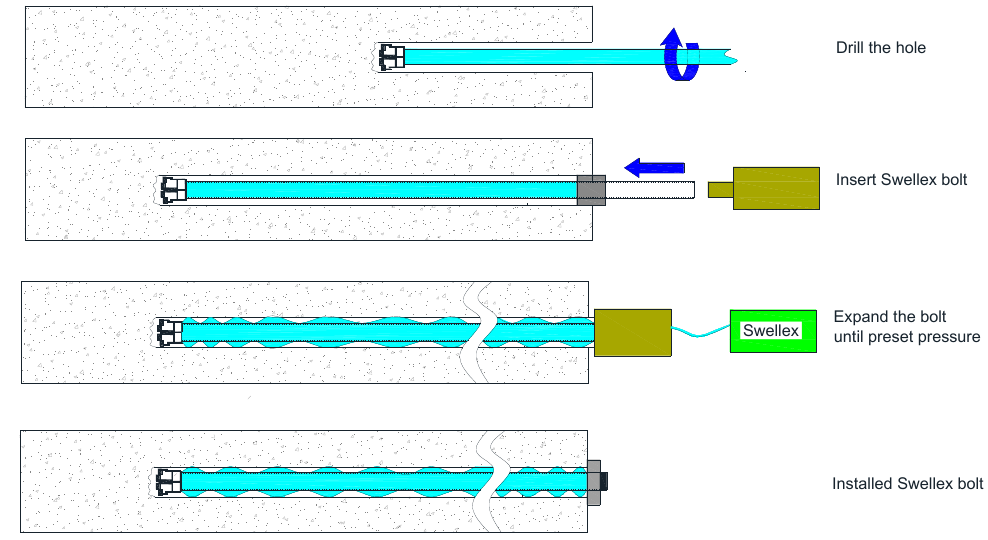
Figure 2. The installation of a Swellex frictional anchored rock bolt.